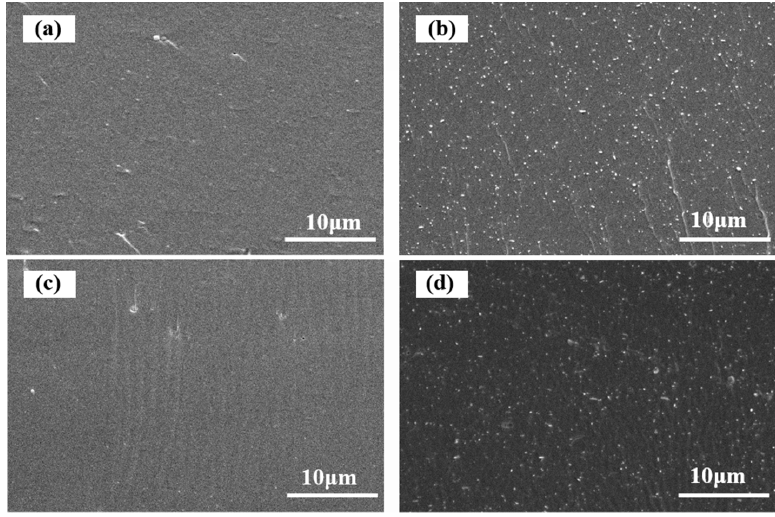
Figure 6. Scanning electron Microscopy (SEM) images of the SPI and PTGE film a ; SPI, PTGE, and HNTs film b ; SPI, PTGE, and CMCS film c ; SPI, PTGE, HNTs, and CMCS film d . The nanoscale topography for the surface of the SPI-based films was also explored by AFM. The height images and 3D topography of the films are shown in Figure 7.